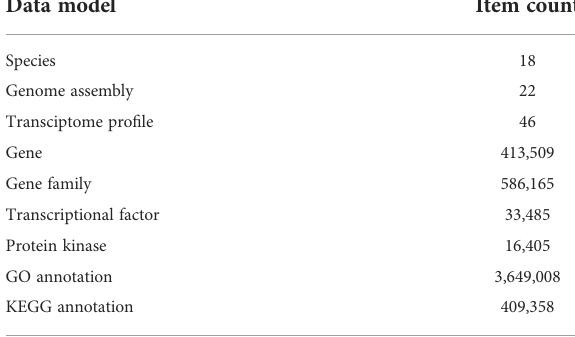
TABLE 1 Data statictis of dataset in genomics respository of oil plant.